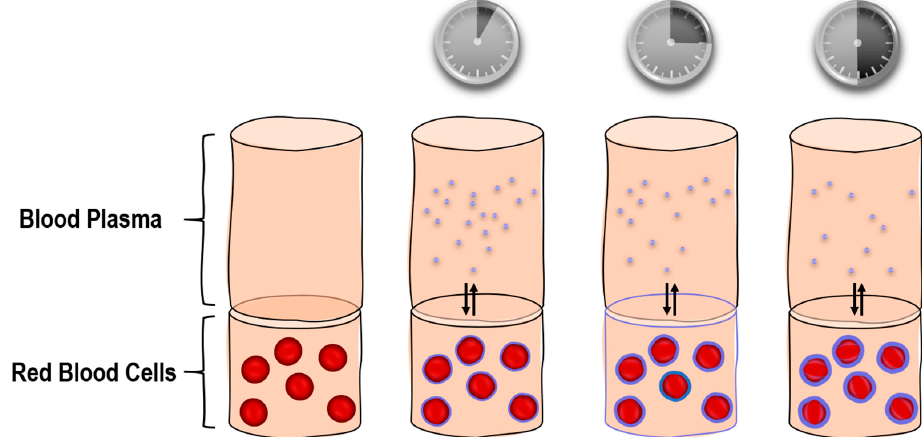
Figure 4. Schematic representation of the distribution assay between the red blood cells and the blood plasma . To quantify the distribution between blood and plasma, the blood-to-plasma rate ratio ( K Blood/Plasma ) and the erythrocyte-to-plasma rate ratio ( K RBC/Plasma ) of free doxorubicin and the two nanoparticle formulations were determined (supplementary materials, S5).